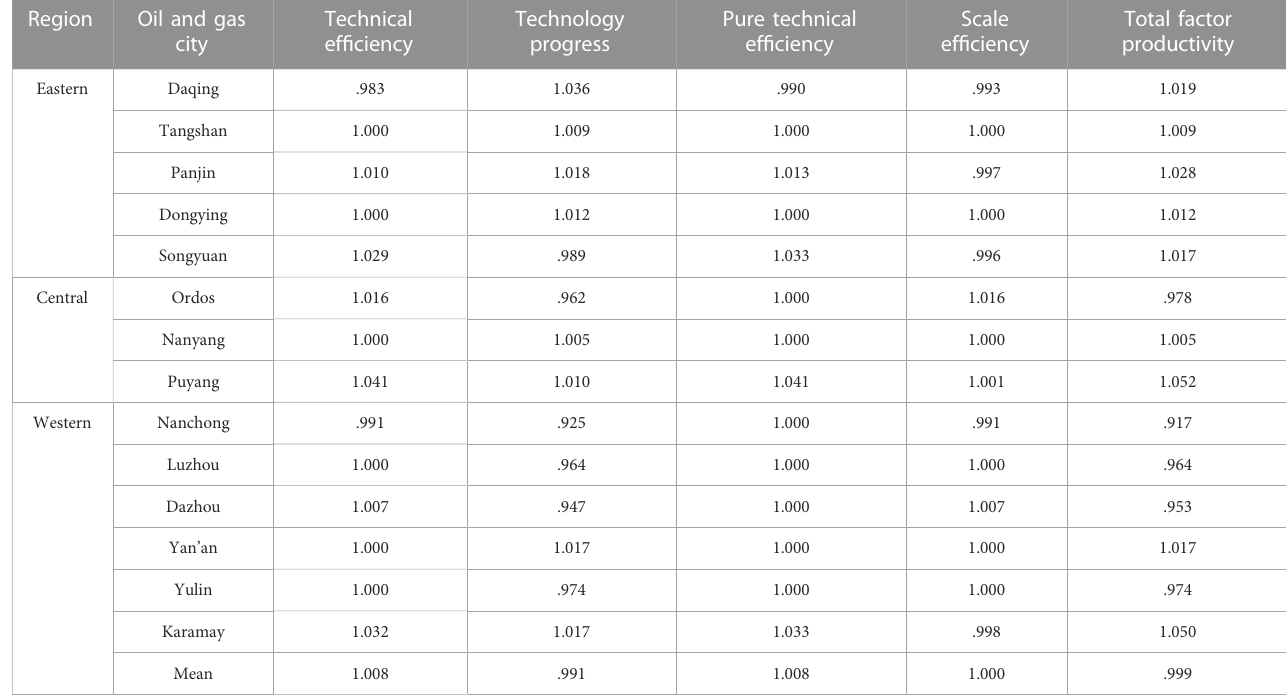
TABLE 4 Malmquist index of annual average industrial green development ef fi ciency and its decomposition in 14 prefecture-level oil and gas cities in 2004 – 2018. Region Oil and gas